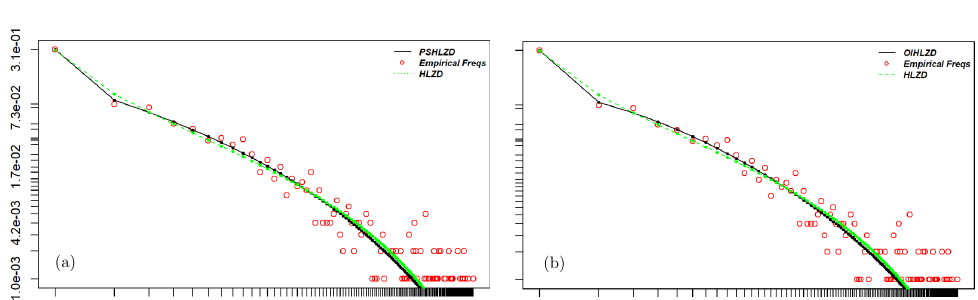
Figure 4. ( a ), the fitted PSHLZD (black solid line) is plotted together with the fitted HLZD (green dotted line) and the IT empirical frequencies (red dot line) for the sample of Trapani Dry . ( b ) the fitted OIHLZD (black solid line) is plotted together with the fitted HLZD (green dotted line) and the IT empirical frequencies (red dot line) for the same sample.